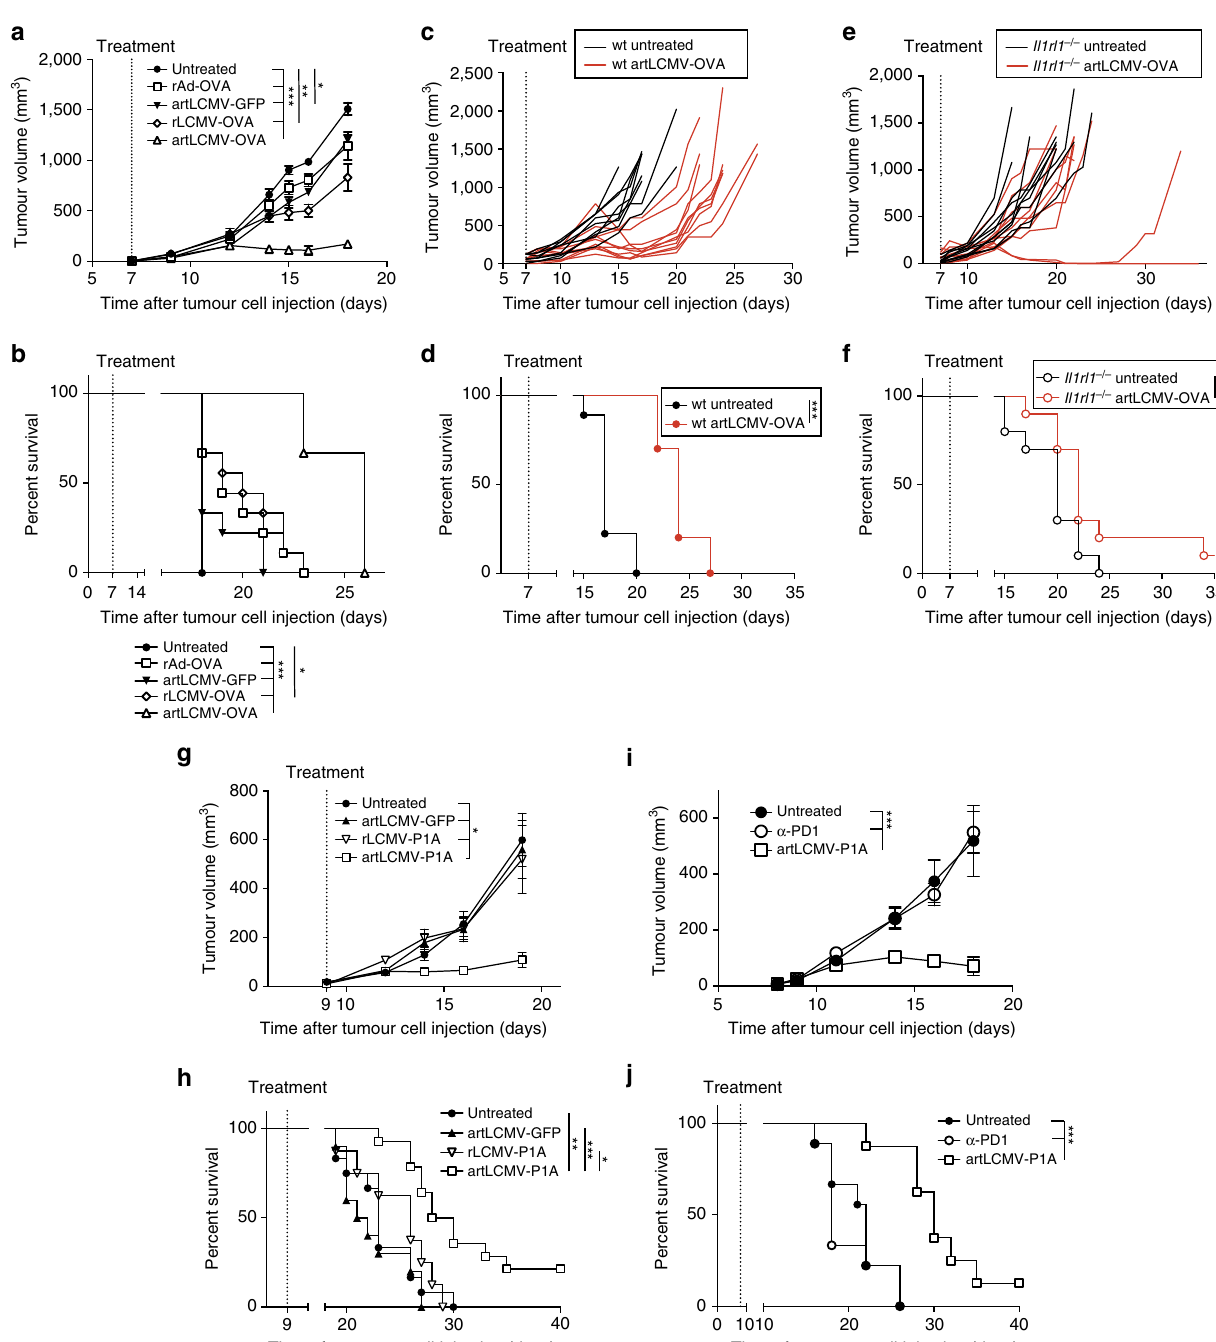
Figure 6 | artLCMV-based immunotherapy affords antigen-specific and ST2-dependent tumour control. ( a , b ) We implanted EG7-OVA tumour cells subcutaneously into the flank of C57BL/6 mice. On day 7, when tumours became palpable, we treated them with artLCMV-OVA, artLCMV-GFP, rLCMV-OVA, rAd-OVA or left them untreated. Tumour growth over time ( a , terminated when the first animal was lost from follow-up owing to humane endpoint) and survival curves ( b ) are shown. Symbols represent the mean ± s.e.m. of nine mice per group. N ¼ 3. ( c – f ) We implanted EG7-OVA tumour cells subcutaneously into the flank of C57BL/6 (wt, c , d ) and ST2-deficient ( Il1rl1 (cid:2) / (cid:2) , e , f ) mice. When tumour masses became palpable on d7, we treated them with artLCMV-OVA (red lines) or left them untreated (black lines). Tumour growth ( c , e , lines depict individual mice) and Kaplan–Meier survival curves ( d , f , n ¼ 9 (wt untreated), n ¼ 10 (other groups)) are shown. N ¼ 2. ( g , h ) We implanted P815 tumour cells subcutaneously into the flank of DBA/2 mice. When tumour masses became palpable on d9, we treated them with artLCMV-P1A, artLCMV-GFP, rLCMV-P1A or left them untreated. Tumour volumes ( g , mean ± s.e.m.) and Kaplan–Meier survival curves based on humane endpoints ( h ) show combined data of nine (rLCMV-P1A), 12 (untreated, artLCMV-GFP) and 14 mice per group (artLCMV-P1A) from two independent experiments. N ¼ 2. ( i , j ) DBA/2 mice bearing P815 tumors as in g , h were treated on d9 with artLCMV-P1A or 12.5mgkg (cid:2) 1 anti-PD1 antibody on d15 (earliest possible onset of the artLCMV-P1A-induced CTL response), d18, d22 and d25. Tumor volumes ( i , mean ± s.e.m.) and survival rates ( j ) of eight (artLCMV-P1A) or nine mice per group (untreated, a -PD1) are shown. We analysed tumour growth curves in a , g , i by comparing the area under the curve (AUC) using one-way ANOVA with Bonferroni post hoc test. Survival data in b , d , f , h , j were analysed by log-rank tests with Bonferroni correction in b , h , j . NS, not significant; * P o 0.05, ** P o 0.01 and *** P o